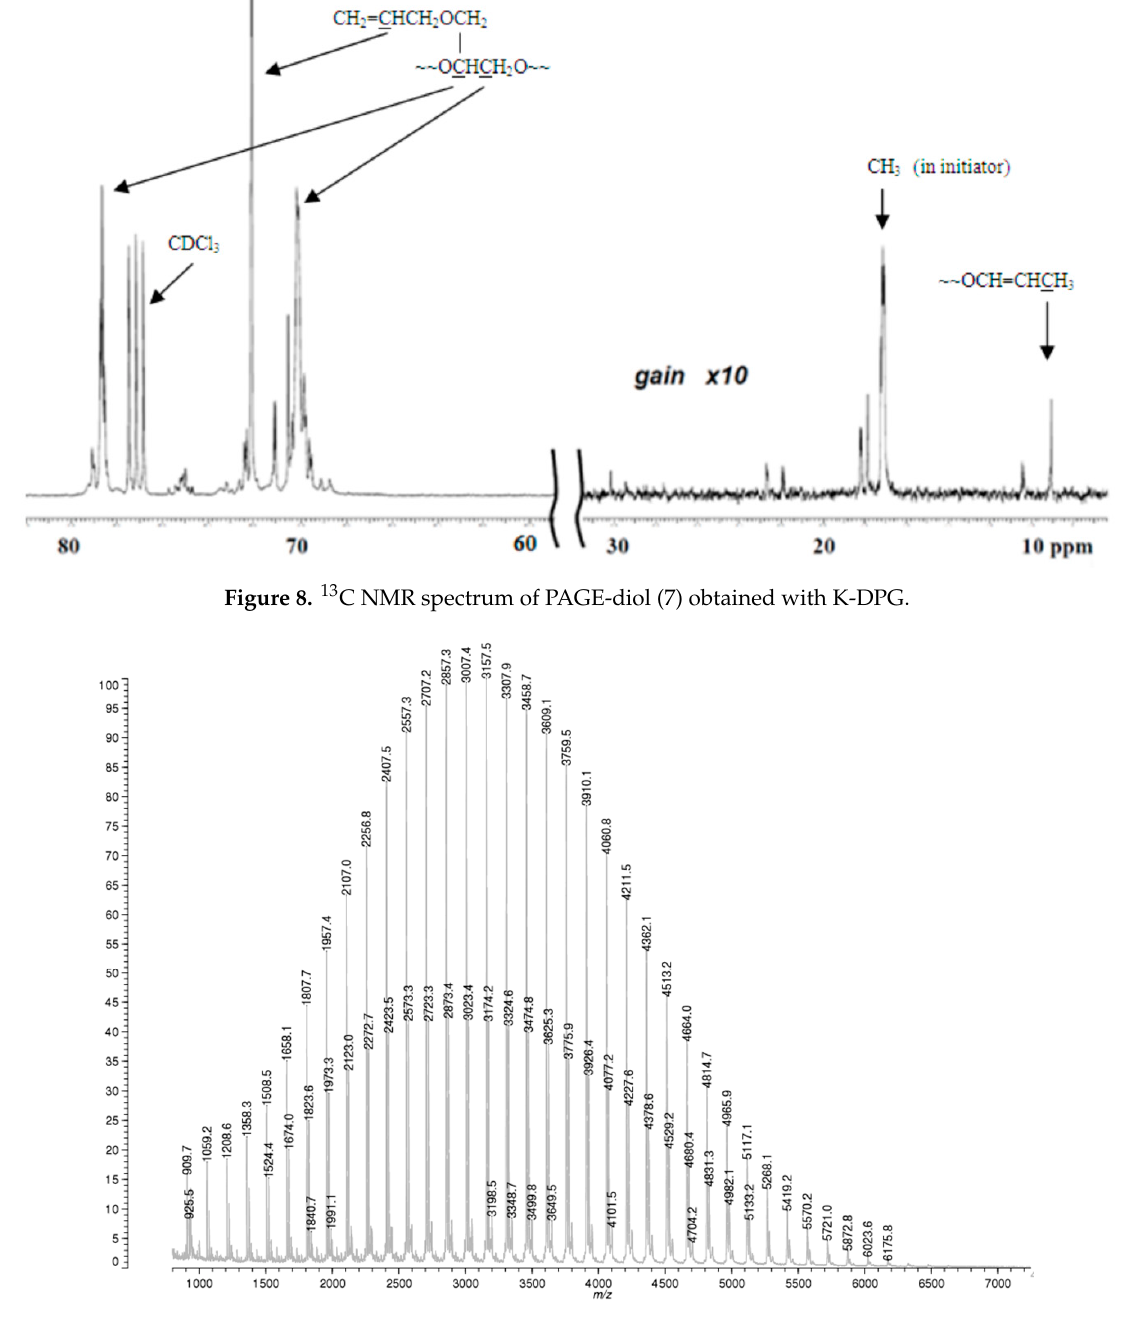
Figure 9. MALDI-TOF spectrum of PPGE-diol (11) synthesized with K-DPG/L.